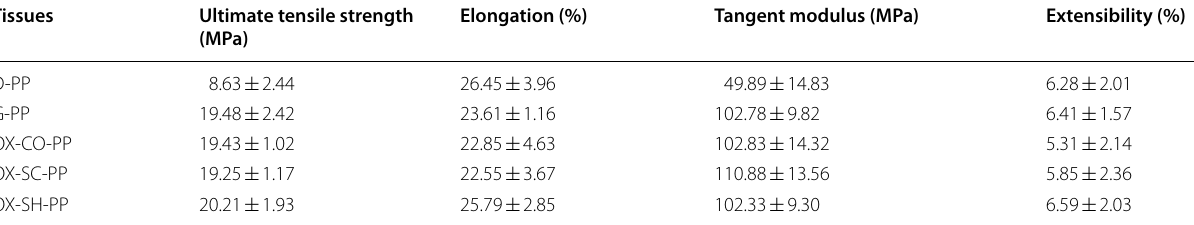
Table 1 Mechanical properties of PPs